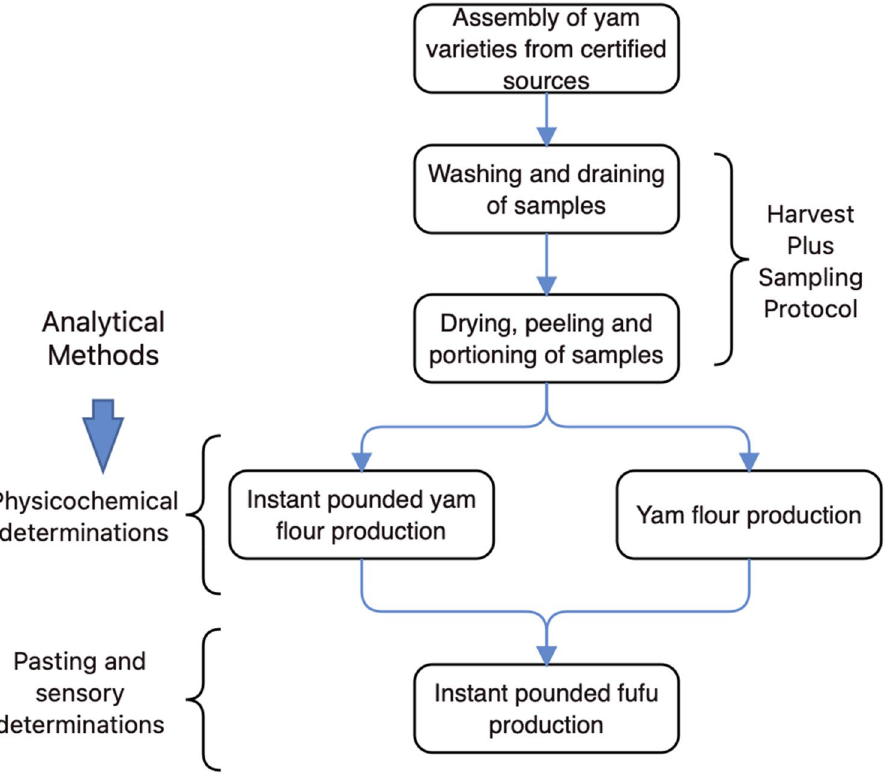
Figure 1. The schematic overview of the experimental program is shown in Fig. 1, from the assembly of yam varieties from certified sources, the processing stages from washing to portioning, the making of instant pounded and yam flour groups, then, instant pounded yam fufu , and at the same time, the analytical methods of physicochemical, as well as pasting and sensory